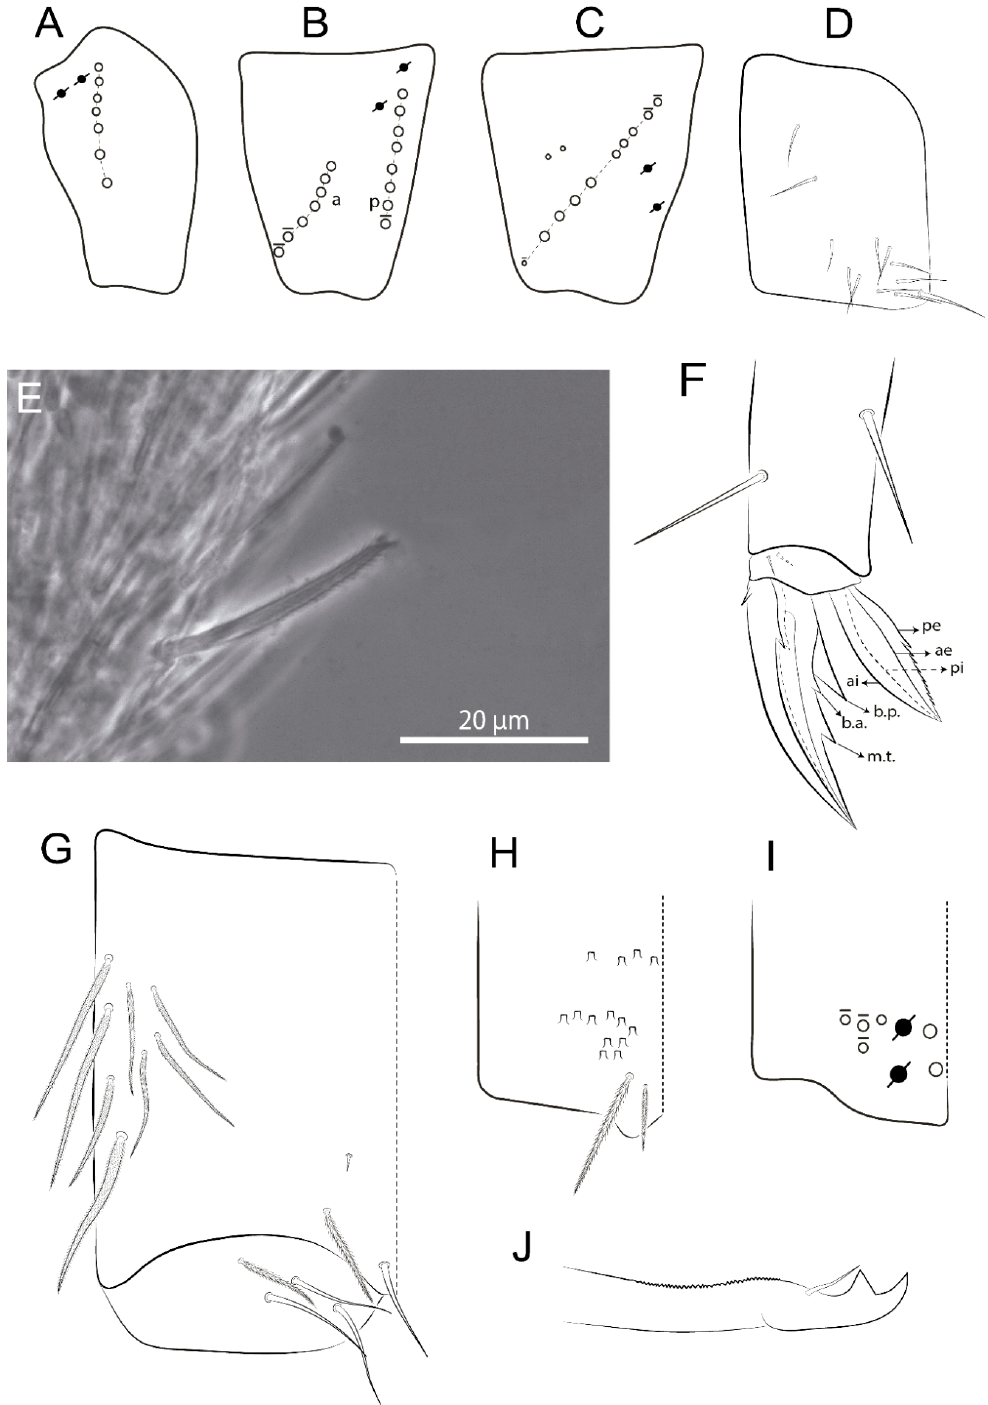
Figure 57. Pseudosinella neriae sp. nov.: trunk appendages. ( A–C ) subcoxa I–III, respectively; ( D ) trochanteral organ; ( E ) modified chaeta of tibiotarsus II; ( F ) distal tibiotarsus and empodial complex III (anterior view); ( G ) collophore (lateral view); ( H ) distal part of manubrium (ventral view); ( I ) manubrial plate (dorsal view); ( J ) distal dens and mucro (inner view).